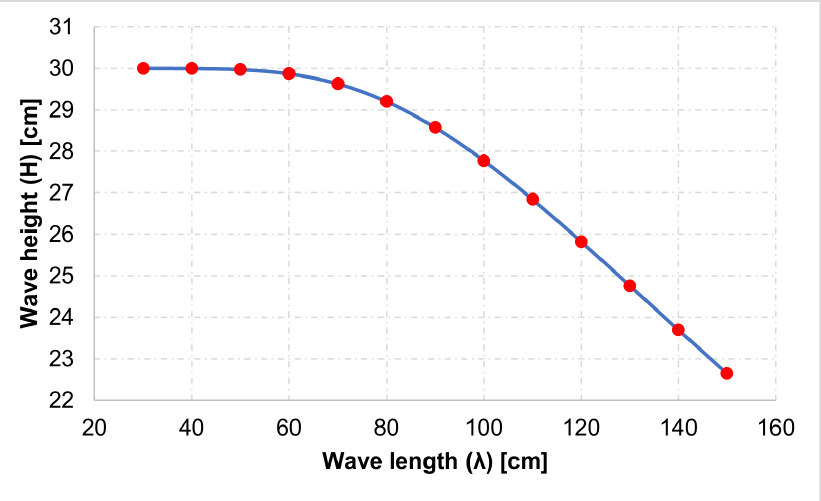
Figure 7. Wave height variation based on the defined wave length